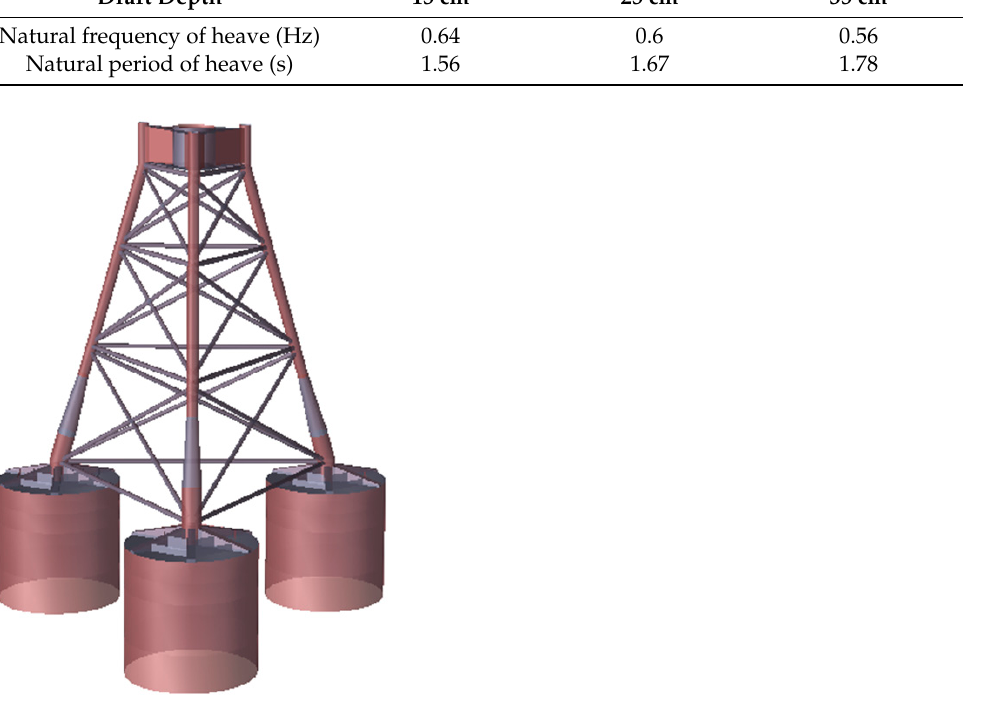
amplitudes of heave and roll at different drafts were calculated. The period corresponding